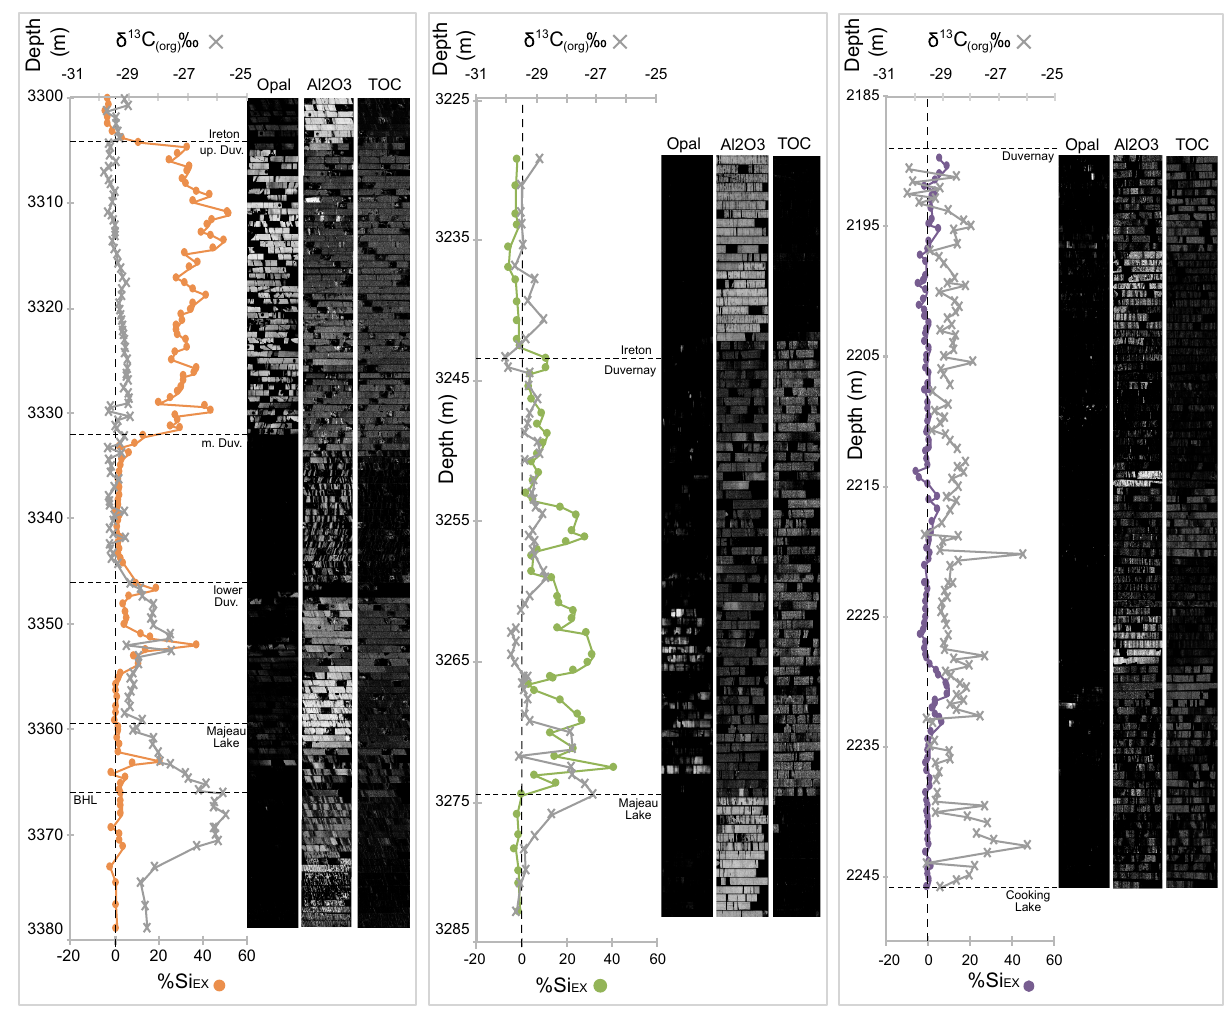
Figure 2. Si EX , and δ 13 C (org) plotted versus depth; LWIR hyperspectral images of detected opal-A, and predicted Al 2 O 3 , and TOC (LWIR; greyscale). The dashed line refers to 0% Si EX . Left, middle, and right panels correspond to Kabob, Willesden Green and East Shale Basin respectively. The greyscale images have minimum and maximum image line values for opal-A index, %Al 2 O 3 , and %TOC of: 0.0–5.2, 0.0–19.5 (15.2), 0.0–4.2 (4.35) (Kaybob); 0.0–5.4, 0.0–15.2 (15.9), 0.0–5.5 (13.2) (Willesden Green); 0.0–4.3, 0.0–18.3(11.4), 0.0–4.1 (9.8) (East Shale